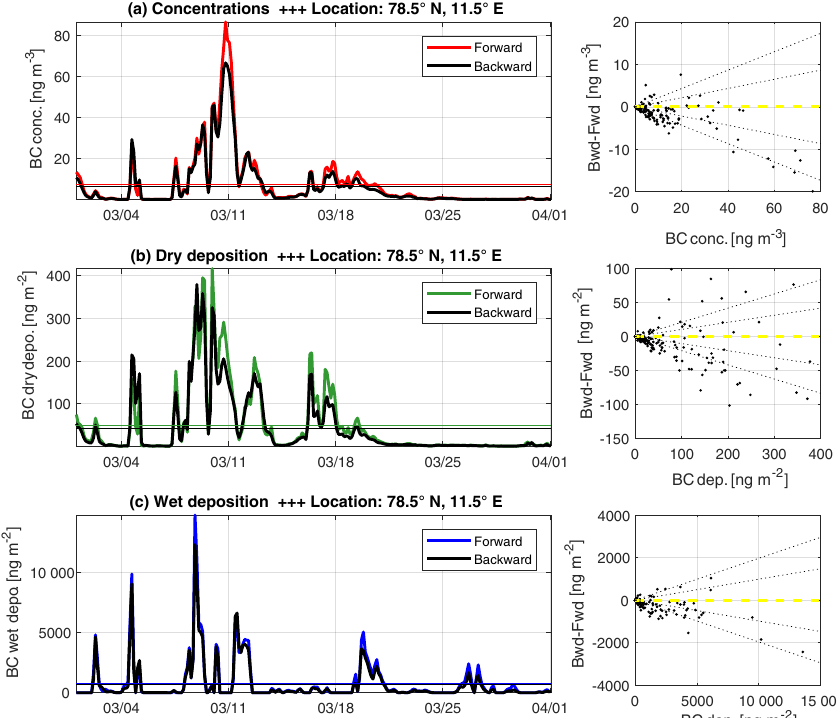
Figure 6. Same as Fig. 4, but for the receptor point